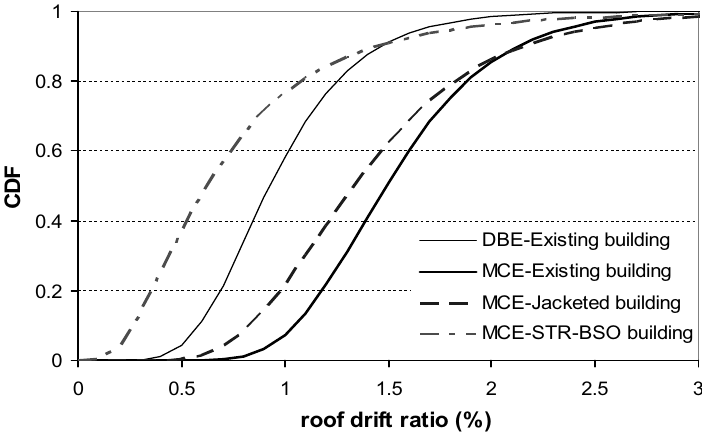
Fig. 6. CDFs for maximum roof drift